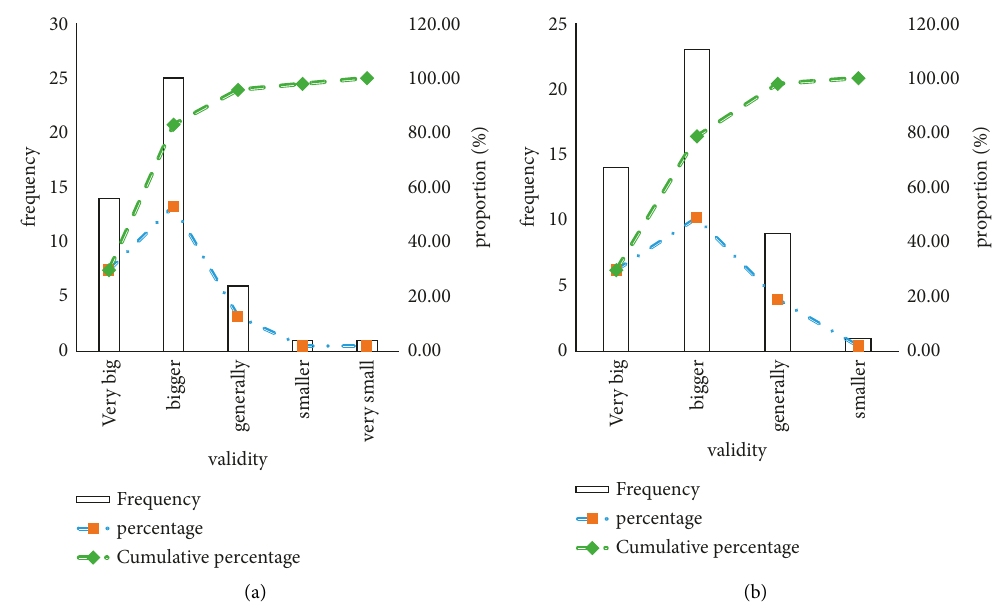
Figure 9: The effect of martial arts education on developing sports habits and developing physical strength: (a) the effect of martial arts on the formation of sports habits and (b) the effect of martial arts on the development of physical